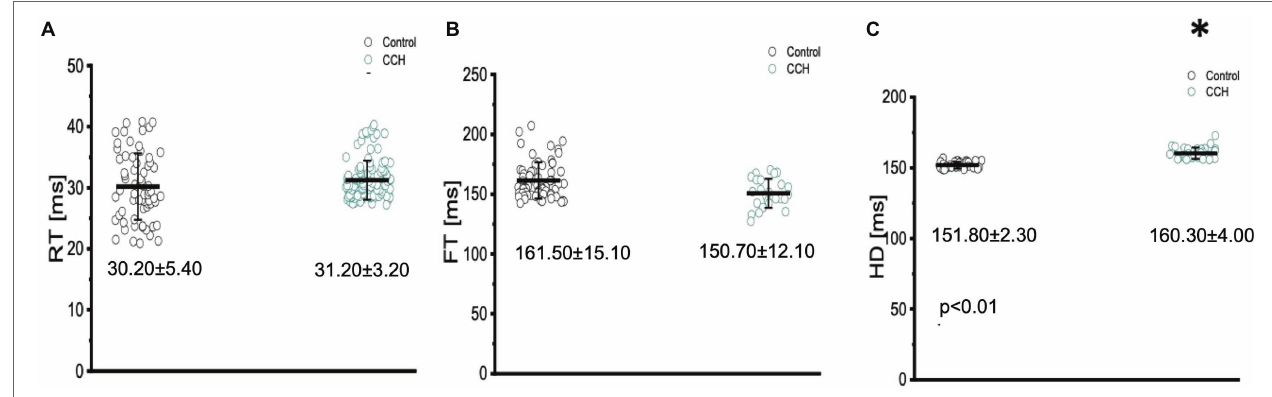
FIGURE 12 | The three kinetical properties of the Ca 2+ transient, including the rise time (RT), fall time (FT), and half duration (HD) before (black) and after (green) perfusion with 5 μ m carbamylcholine. Administration of 5 μ m carbamylcholine did not significantly increase the rise time of the Ca 2+ transient from 30.20 ± 5.40 ms to 31.20 ± 3.20 ms ( p > 0.01, n = 69 for the control, n = 85 for CCH, N = 8; A ) or decrease the fall time (FT) from 161.50 ± 15.10 ms to 150.70 ± 12.10 ms ( p > 0.01, n = 59 for the control, n = 27 for CCH, N = 8; B ). However, the half duration of the Ca 2+ transient significantly increased from 151.80 ± 2.30 ms to 160.30 ± 4.00 ms ( p < 0.01, n = 29 for the control, n = 31 for CCH, N = 8; C ). * Denotes a significant difference between the two distributions. The data are presented as multiple measurements ( n ; dot cloud) recorded for different measurements ( n ) on different hearts ( N ) with the mean ± SEM (solid